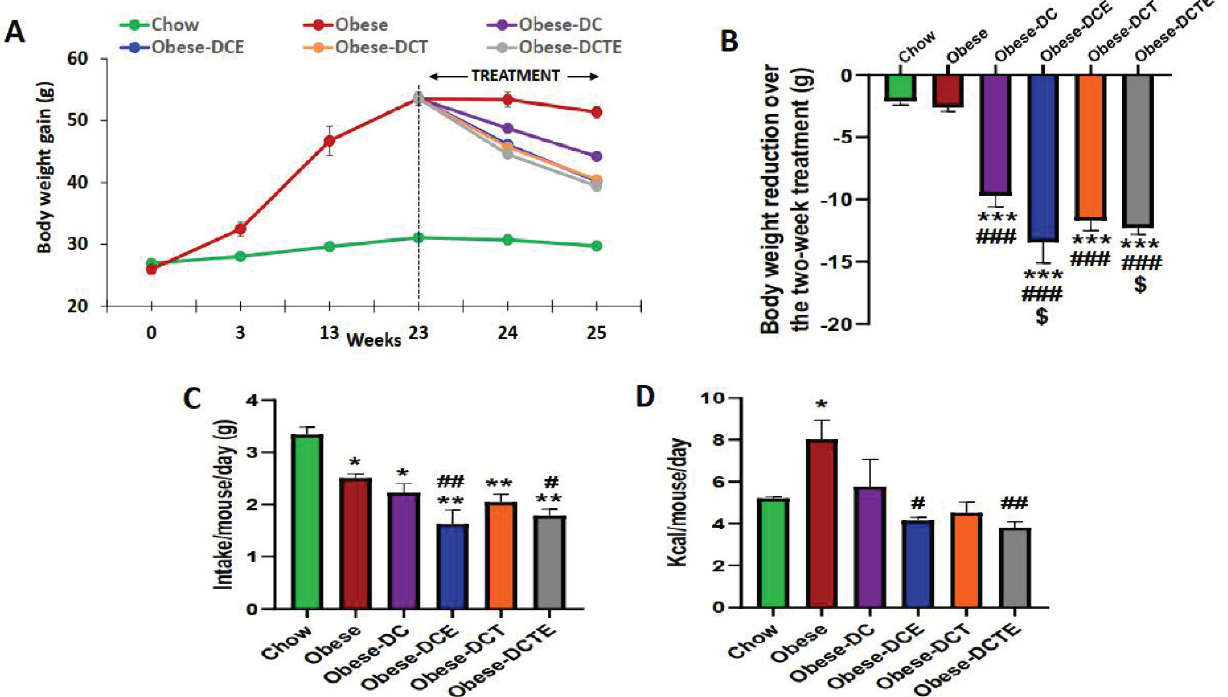
Figure 1. Body weight gain ( A ); Body weight reduction during the two weeks of treatment (week 23 to week 25) ( B ); Food intake during the two weeks of treatment (g/mouse/day); ( C ) Caloric intake during the two weeks of treatment (Kcal/mouse/day) ( D ). Chow = mice fed a standard diet for 25 weeks; Obese = mice fed a high fat (60% kcal from fat)/high sucrose diet for 25 weeks; DC = mice fed a high fat (60% kcal from fat)/high sucrose diet for 23 weeks and switched to a diet with lower caloric intake (25% kcal from fat) for two weeks; DCE = mice fed a high fat (60% kcal from fat)/high sucrose diet for 23 weeks and switched to a diet with lower caloric intake (25% kcal from fat) supplemented with CSAT+ ® for two weeks; DCT = mice fed a high fat (60% kcal from fat)/high sucrose diet for 23 weeks and switched to a diet with lower caloric intake (25% kcal from fat) and subjected to aerobic training for two weeks; DCTE = mice fed a high fat (60% kcal from fat)/high sucrose diet for 23 weeks and switched to a diet with lower caloric intake (25% kcal from fat) supplemented with CSAT+ ® and subjected to aerobic training for two weeks. Values are represented as mean ± SEM; n = 8–10 mice/group. * p < 0.05 vs. chow; ** p < 0.01 vs. chow; *** p < 0.001 vs. chow; # p < 0.05 vs. obese; ## p < 0.01 vs. obese; ### p < 0.001 vs. obese; $ p < 0.05 vs. obese-DC. Data of organ weights with respect to the length of the left tibia of mice from the different experimental groups are represented in Table